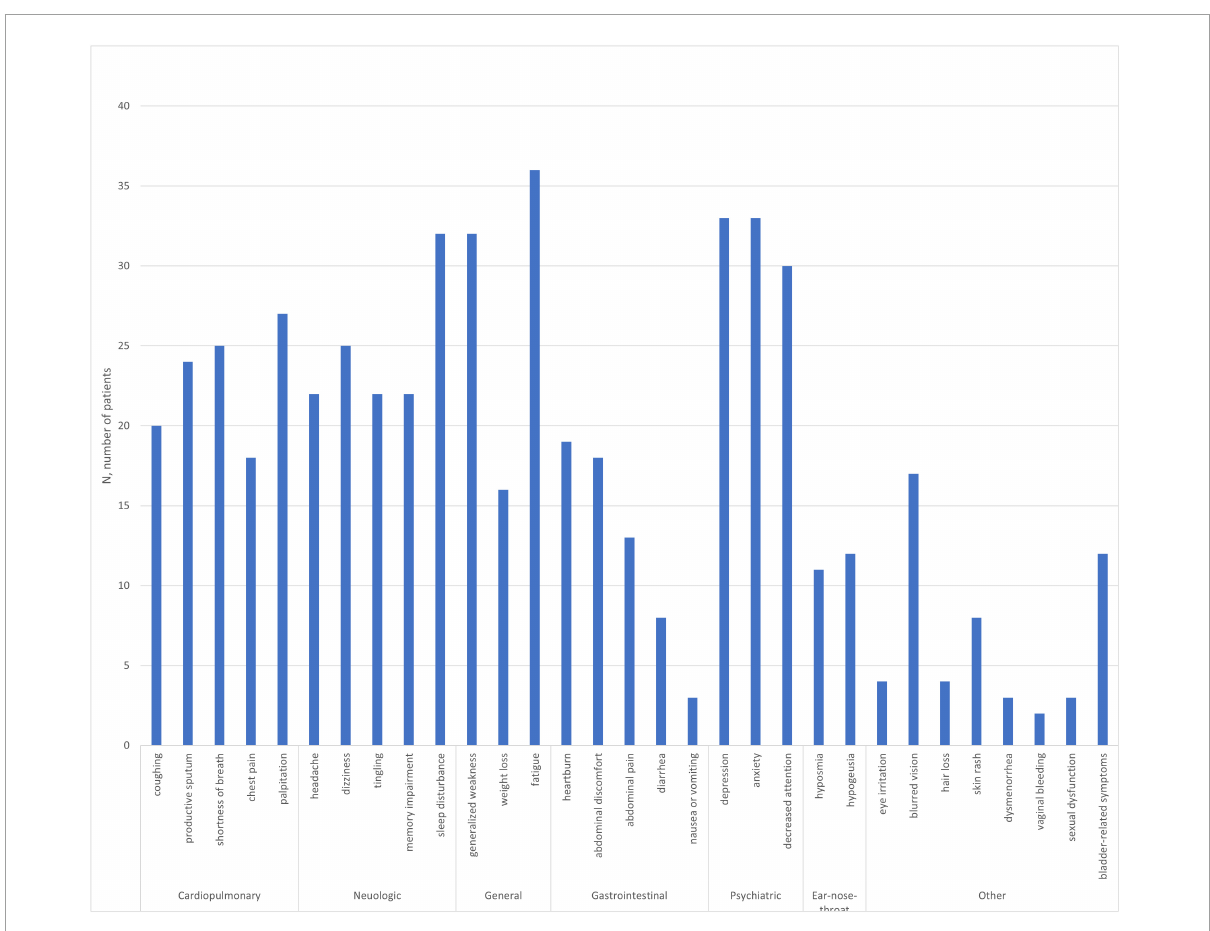
FIGURE1 Subjective symptoms of the patients with subacute coronavirus disease referred to the psychiatric clinic ( n = 40).